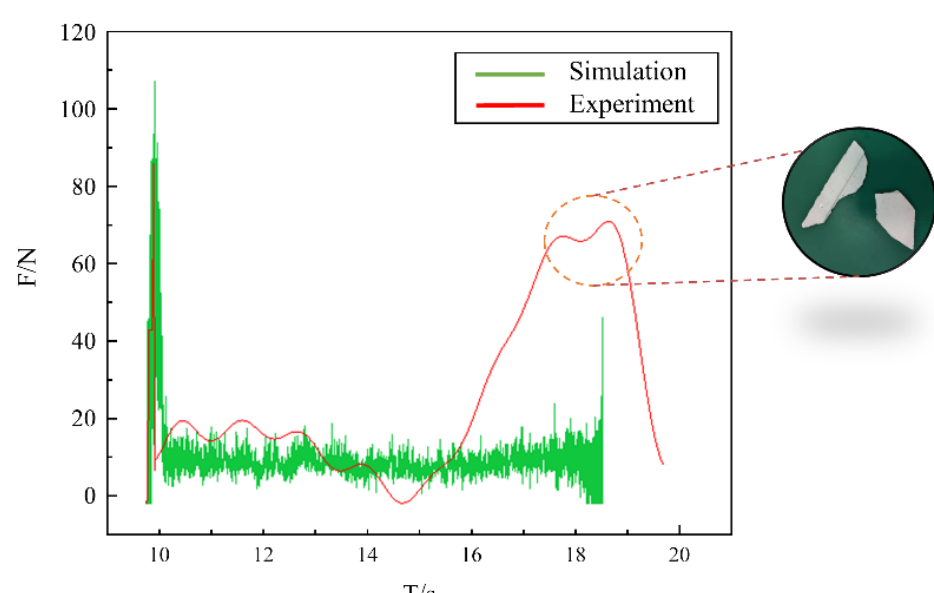
Figure 7. Robotic manipulator machining system.